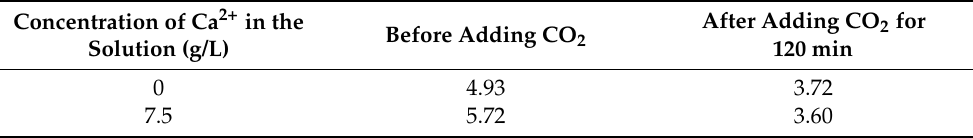
Table 5. pH test results of the test solution.